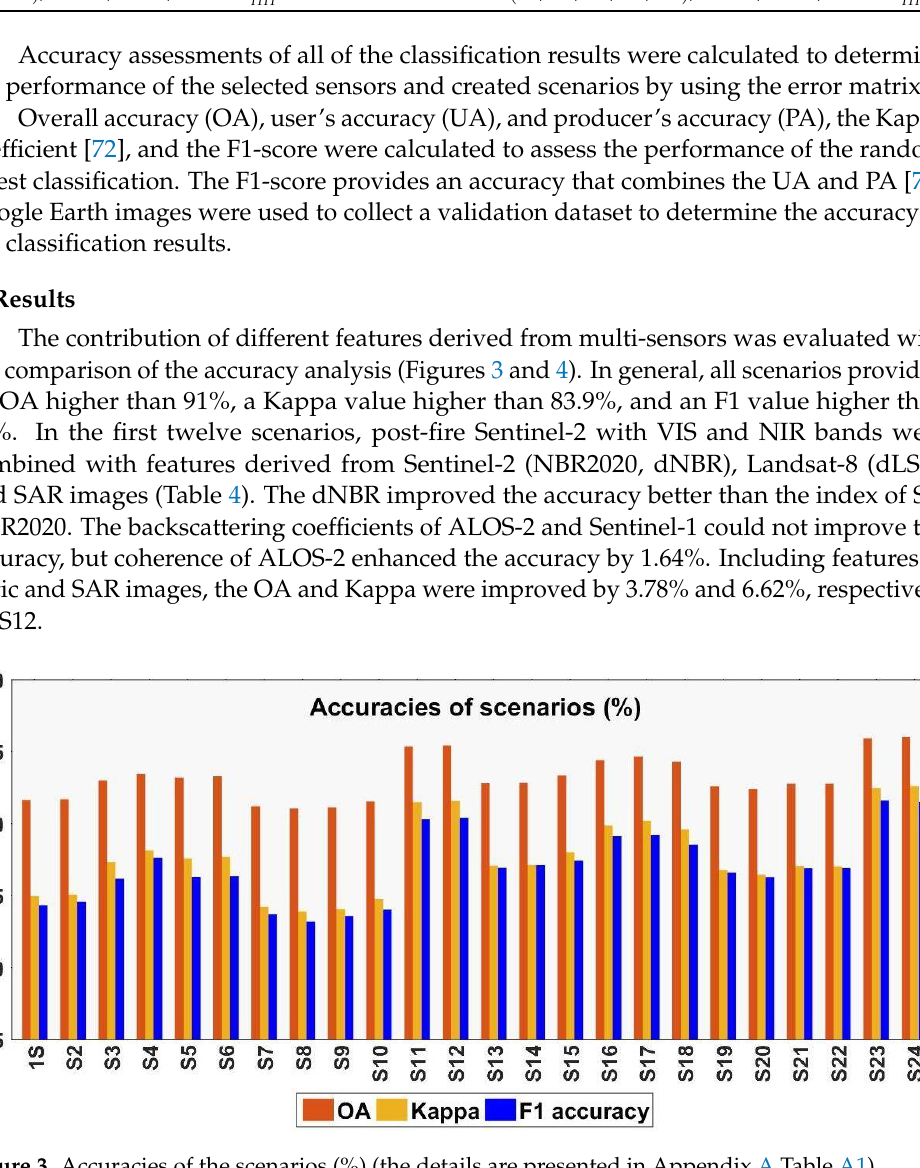
Figure 4. User accuracy (UA) and producer accuracy (PA) of each class (the details are presented in Appendix A Table A2).